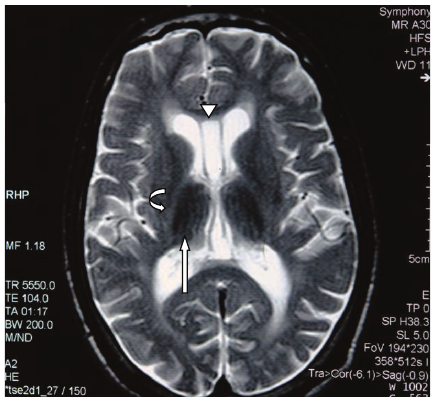
Figure 1: Axial T2 weighted MR image of the brain shows generalized cerebral atrophic changes with associated prominence of cortical sulci. There are high signal intensity changes in the periventricular white matter (arrows) along with some loss of grey matter-white matter differentiation.